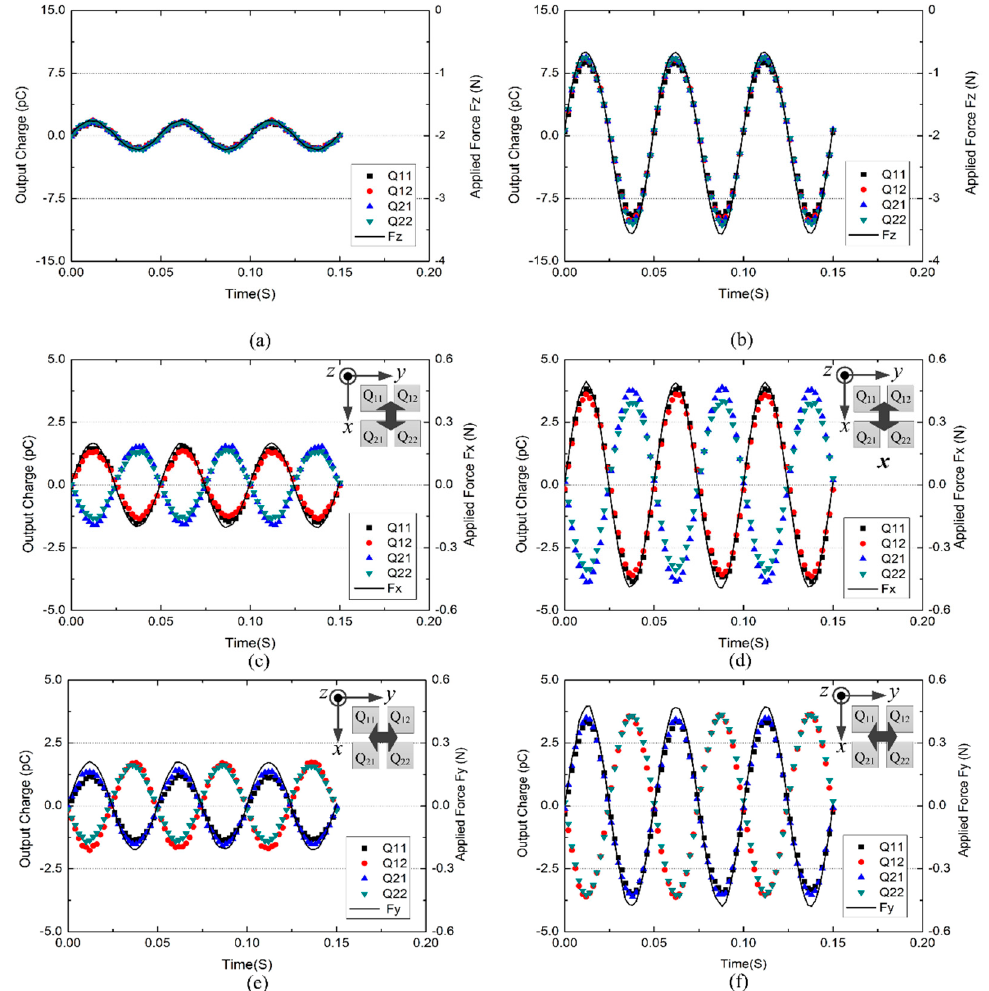
Figure 6. Measured charges of a tactile unit and applied forces in reference six-axis load cell when sinusoidal forces ( f = 20 Hz) in normal and shear directions were applied respectively. ( a ) Normal force with amplitude F zm = 0.24 N; ( b ) normal force with amplitude F zm = 1.45 N; ( c ) shear force in x-axis with amplitude F xm = 0.2 N; ( d ) shear force in x-axis with amplitude F xm = 0.49 N; ( e ) shear force in y-axis with amplitude F ym = 0.21 N; ( f ) shear force in y-axis with amplitude F ym = 0.48 N.